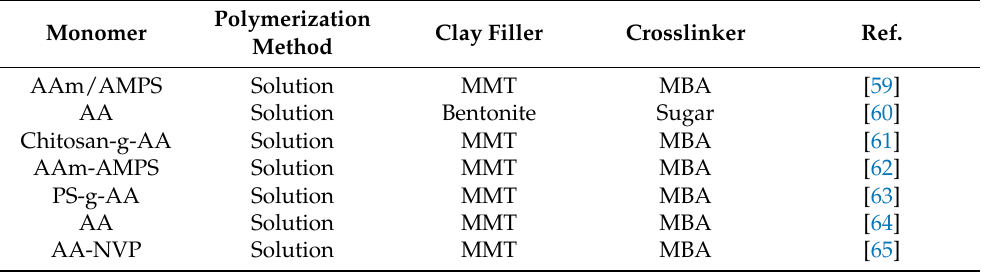
Figure 4. Microstructure of clay–polymer hydrogel. Reproduced with the permission of [56], © 2003 American Chemical Society. Table 1. Clay-reinforced composite hydrogels and their fabrication parameters.